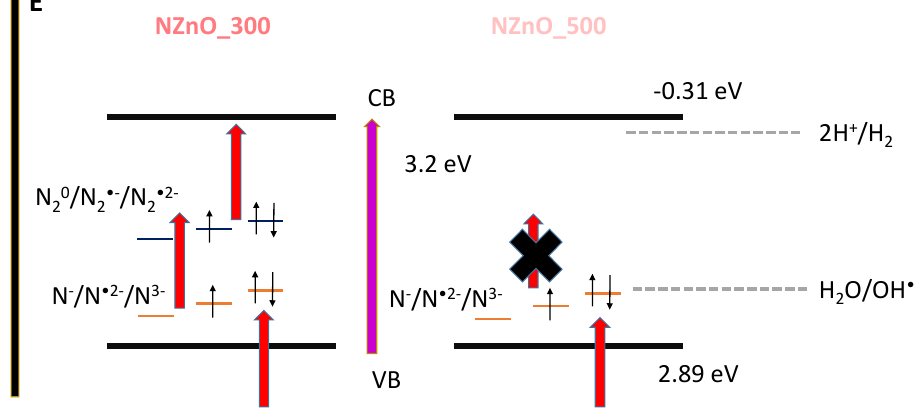
Figure 6. Proposed band diagram for the synthetized NZnO_300 and NZnO_500, respectively. The y-axis represents energy (E). The thick black lines represent the energy position of the valence (VB) and conduction (CB) bands of ZnO. The purple arrow represents the bandgap absorption of 3.2 eV. The dashed lines represent the energy position of the processes described by Equations (1) and (4), respectively. The orange and blue horizontal lines represent the two families of defects present in the materials, while the thin black arrows depict their oxidation and spin states. The red thick arrows represent all the absorption processes involving defect states discussed in the manuscript. The thick black cross on the right-hand side symbolizes a process not active in NZnO_500.